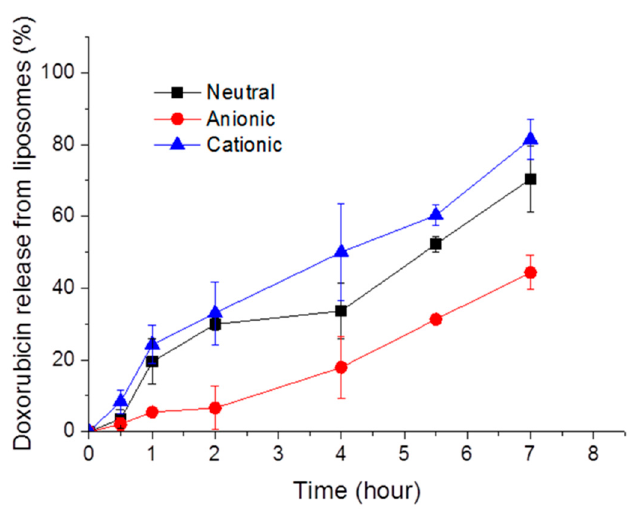
Figure 1. Time-dependent release of doxorubicin from neutral, anionic, and cationic liposomes.